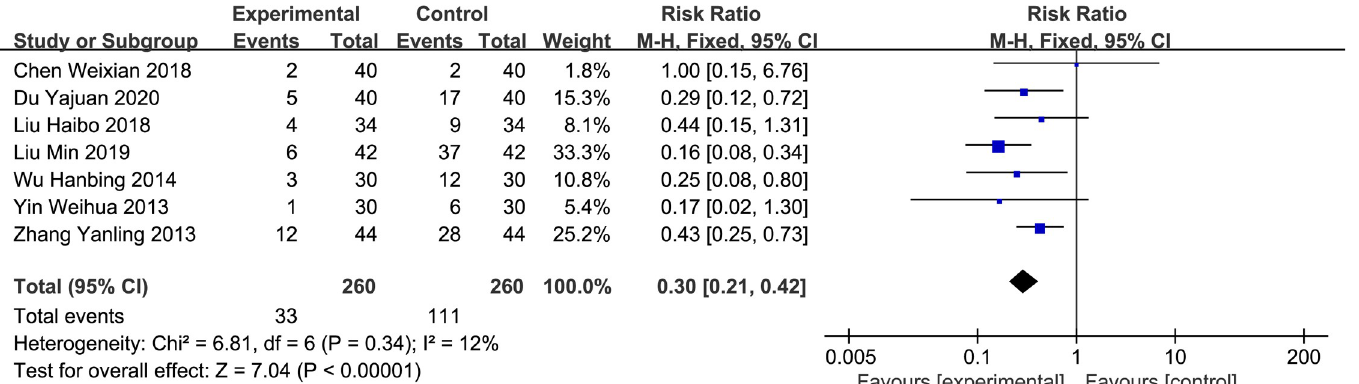
PLOS ONE | https://doi.org/10.1371/journal.pone.0266754 June 27,